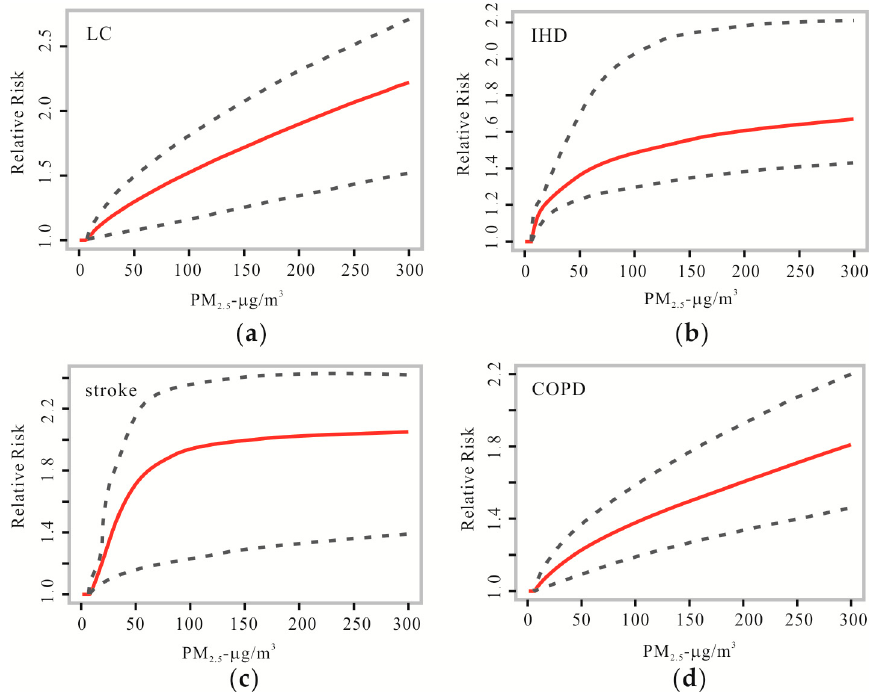
Figure 4. Relationships between the relative risk (RR) of ( a ) lung cancer (LC), ( b ) ischaemic heart disease (IHD), ( c ) stroke, and ( d ) chronic obstructive pulmonary disease (COPD) and the PM 2.5 concentration predicted by the IER model. Red lines and dotted lines represent predicted values of IER model and 95% CIs respectively.